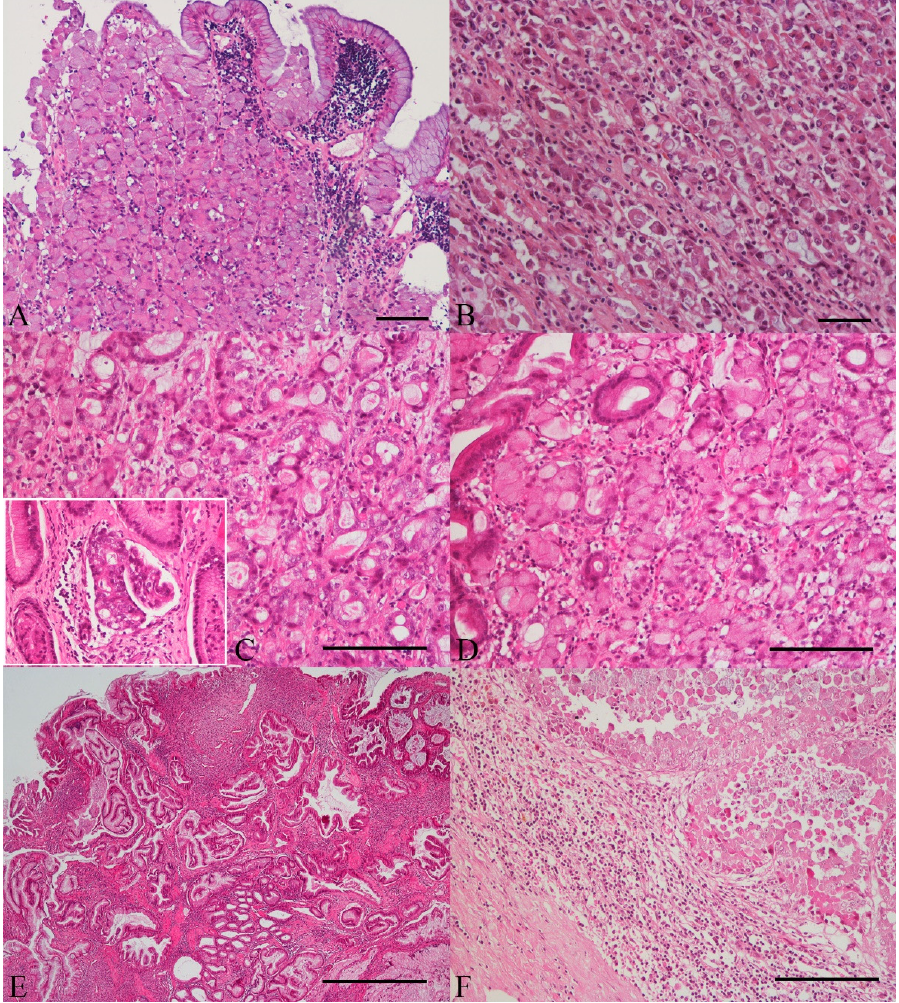
Figure 1. Histopathological features of gastric carcinomas and lymph node metastasis. ( A ) Signet ring cell carcinoma (WHO) and diffuse type carcinoma (Lauren) constituted by signet ring tumor cells replacing gastric mucosa (bar = 100 μ m). ( B ) Poorly cohesive carcinoma (WHO) and diffuse type carcinoma (Lauren) composed of poorly cohesive tumor cells (bar = 100 μ m). ( C and D ) Mixed carcinoma (WHO) and indeterminate type carcinoma (Lauren) composed of a mixture of well- differentiated (tubules of various sizes, C ) and signet ring/poorly cohesive histological components ( D ) (bar = 100 μ m). Inset in C shows neoplastic emboli (200×). ( E ) Tubular carcinoma (WHO) and intestinal type carcinoma (Lauren) characterized by distended, diffuse, or branching tubules of various sizes, sometimes with intraluminal mucus (bar = 500 μ m). ( F ) Lymph node metastasis of a poorly cohesive carcinoma (WHO) and diffuse type carcinoma (Lauren) with large clusters of neoplastic epithelial cells. Few aggregates of lymphoid cells are still discernible at the periphery (bar = 100 μ m).